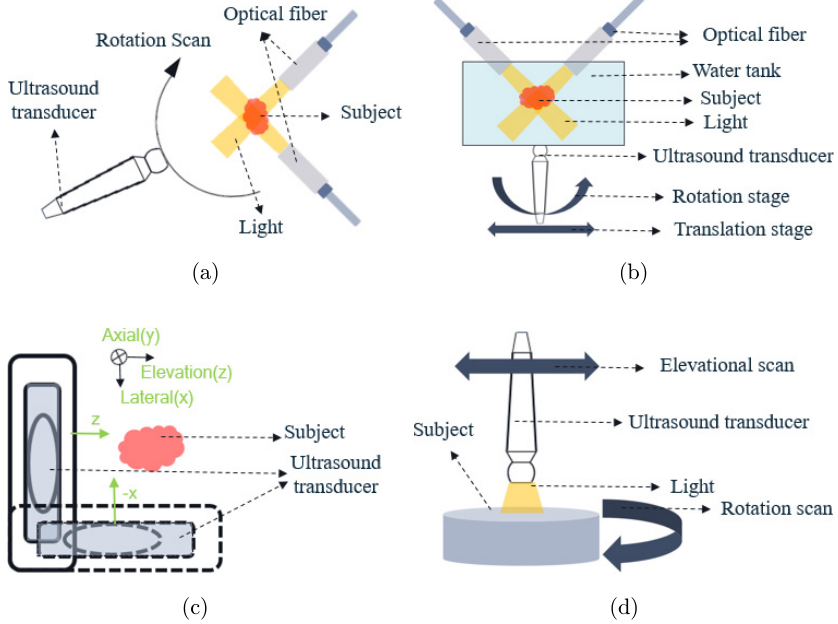
Fig. 3. Di®erent scanning geometries for improving elevation resolution. (a) The rotational scanning geometry proposed in Ref. 28. (b) The translate-tilting scanning geometry proposed in Ref. 29. (c) The bi-directional scanning geometry proposed in Ref. 30. (d) The sample-rotational scanning geometry proposed in Ref.